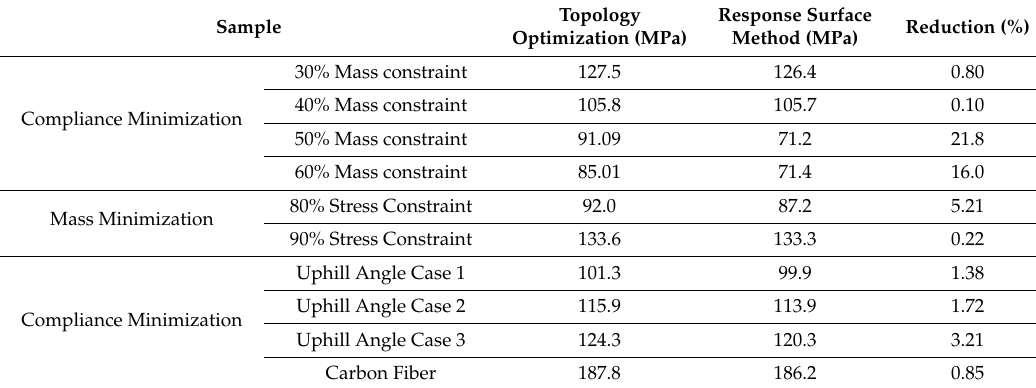
Table 5. Maximum equation Von Mises stress